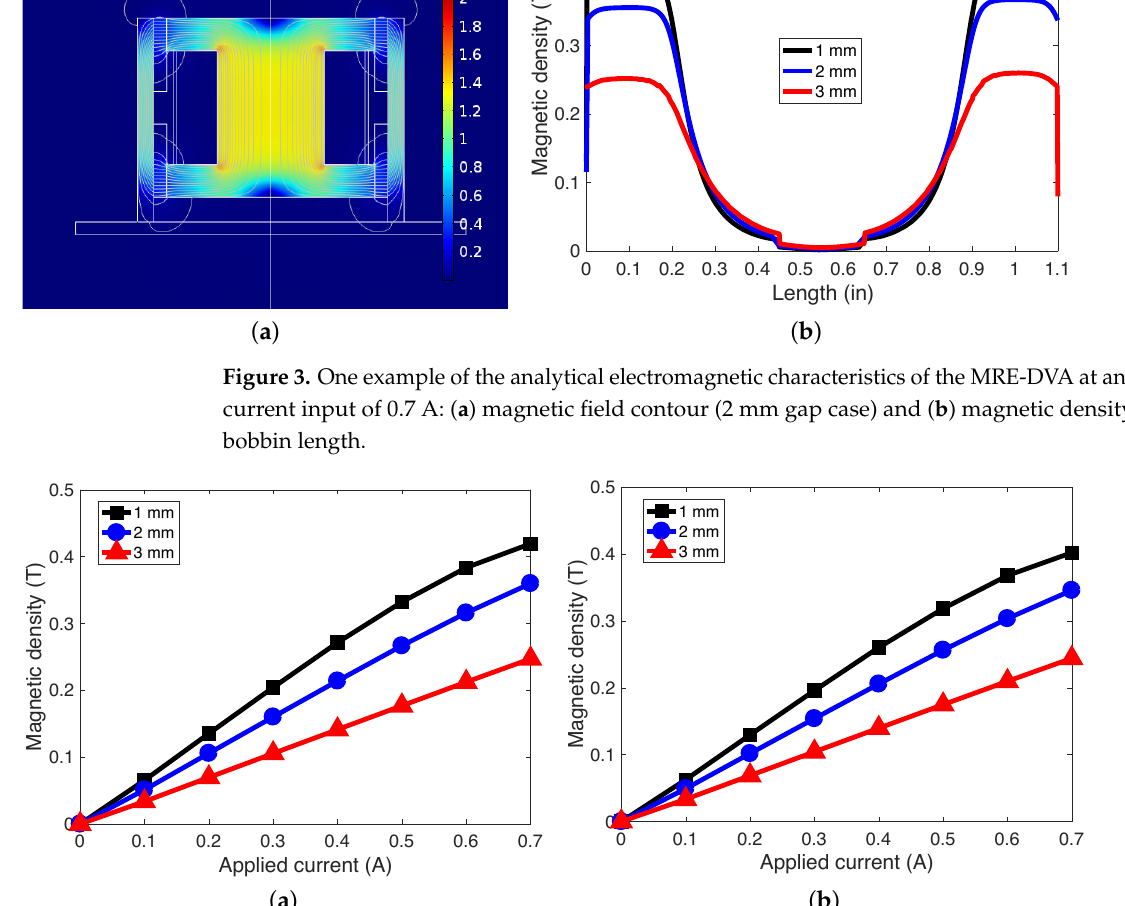
Figure 4. Analytical magnetic flux density as a function of the applied current for the top and bottom active lengths of the MRE-DVA: ( a ) for the top active length (upper MRE pad) and ( b ) for the bottom active length (lower MRE